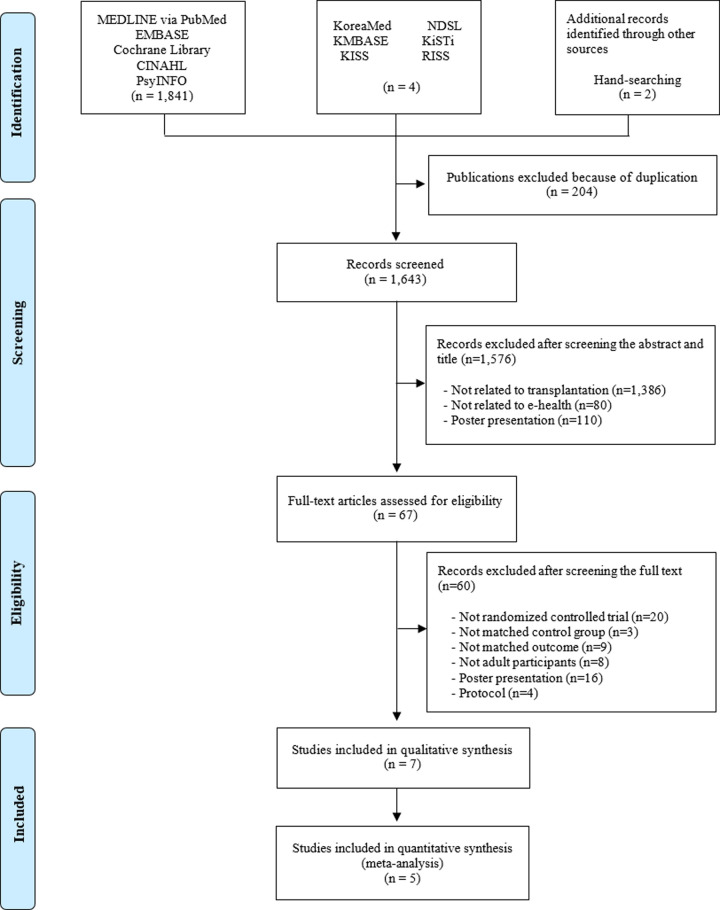
Flowchart of the RCT selection process.